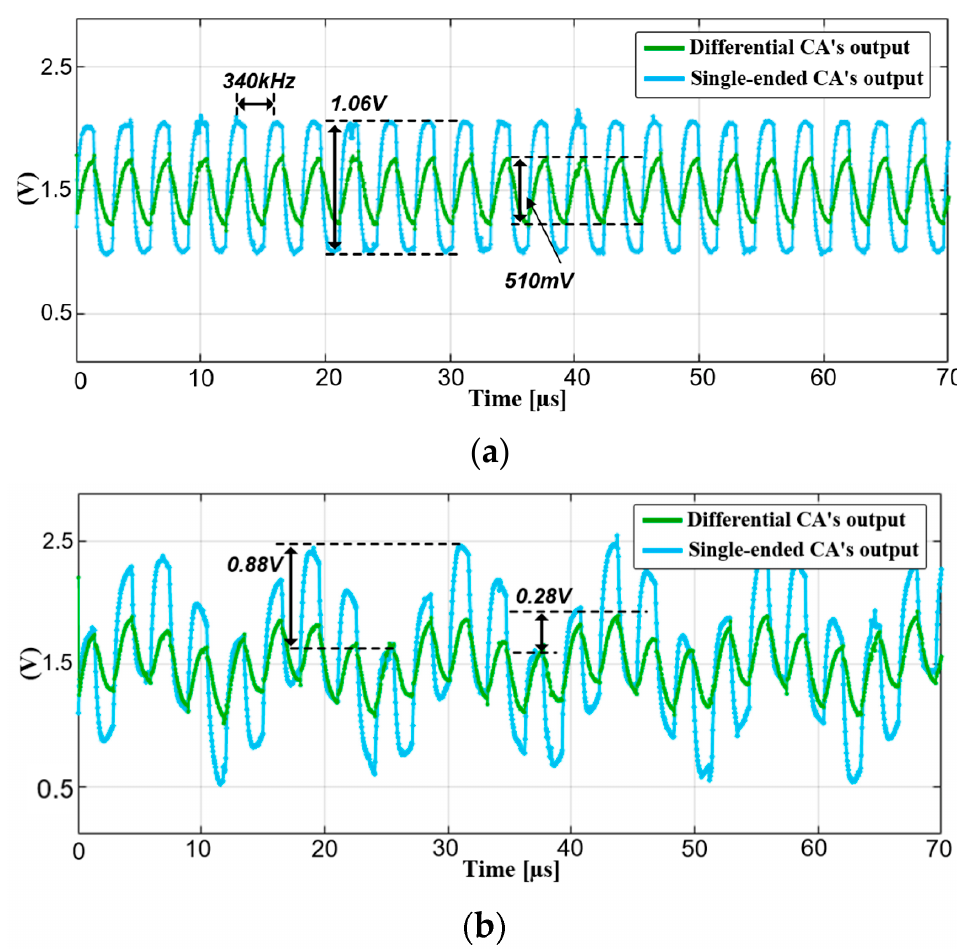
Figure 17. Measured time-varying outputs of differential and single-ended configured CA ( a ) without, and ( b ) with noisy